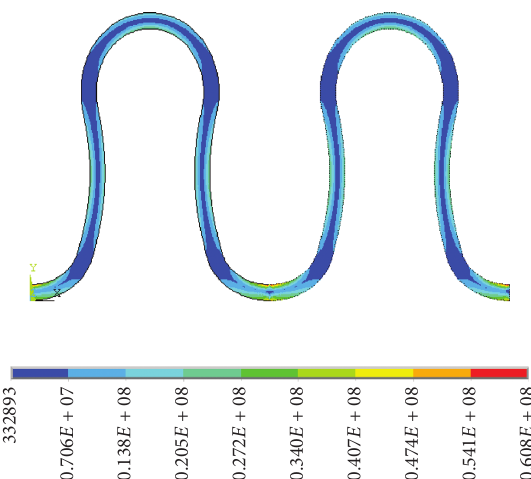
Figure 3: Stress distribution at air inlet and gas outlet side without considering thermal stress (Pa).